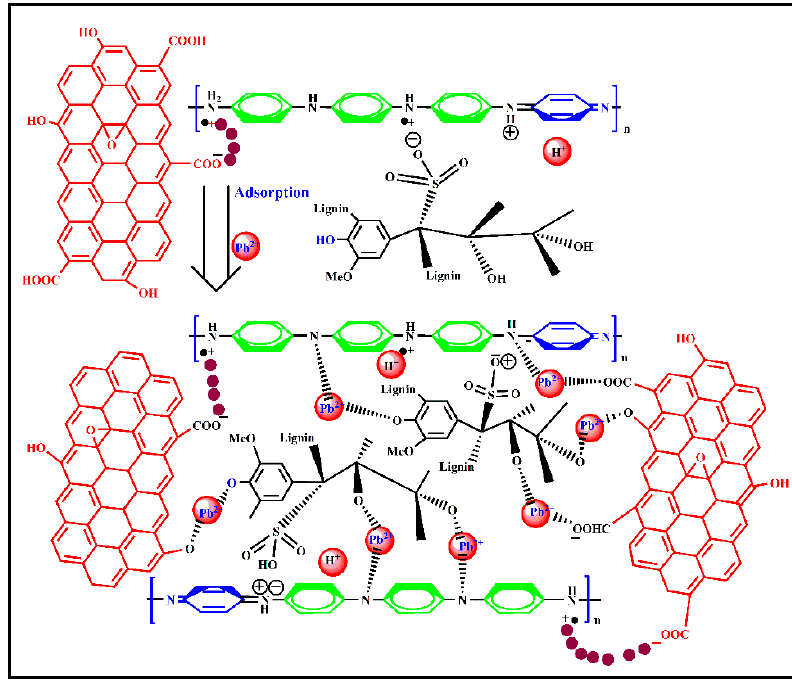
Scheme 4. Possible Pb(II) ion adsorption with LS-GO-PANI ternary composite adsorbent [72].